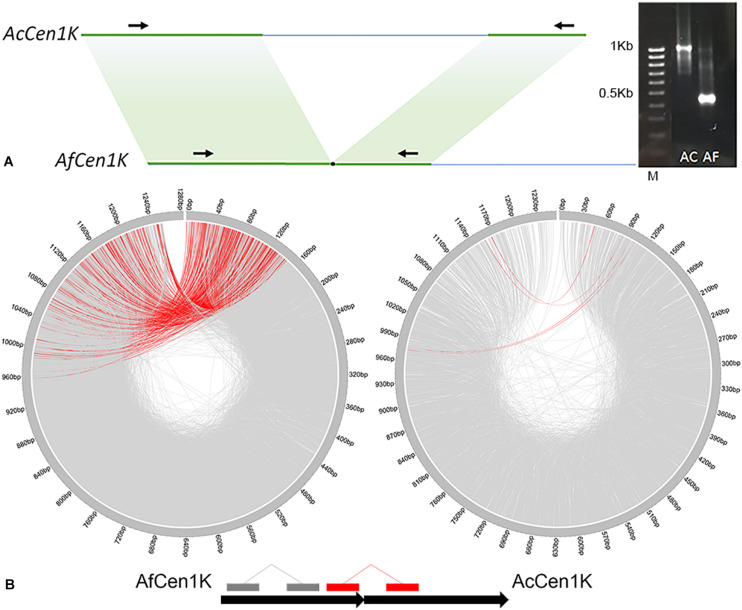
Comparative analysis of AfCen1K and AcCen1K monomer structure. (A) Scheme showing the similar regions between AfCen1K and AcCen1K sequences (green area); Primer positions (black arrows) and gel electrophoresis of the PCR products obtained with these primers for A. cepa (AC) and A. fistulosum (AF) genomic DNA are shown (M – 100 bp DNA Ladder (Syntol)). (B) Circos plot demonstrating the read pairs mapping concordantly (gray lines) and discordantly (red lines) to the reference sequence. The schematic positions of the concordantly and discordantly mapped reads on the two tandemly repeated Af(Ac)Cen1K sequences are illustrated below.